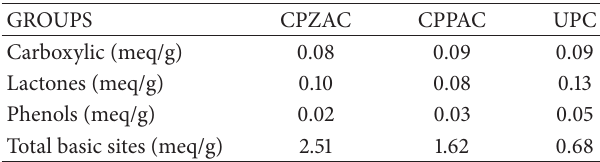
Table 2: Iodine adsorption of samples in relation to their doses. DOSE